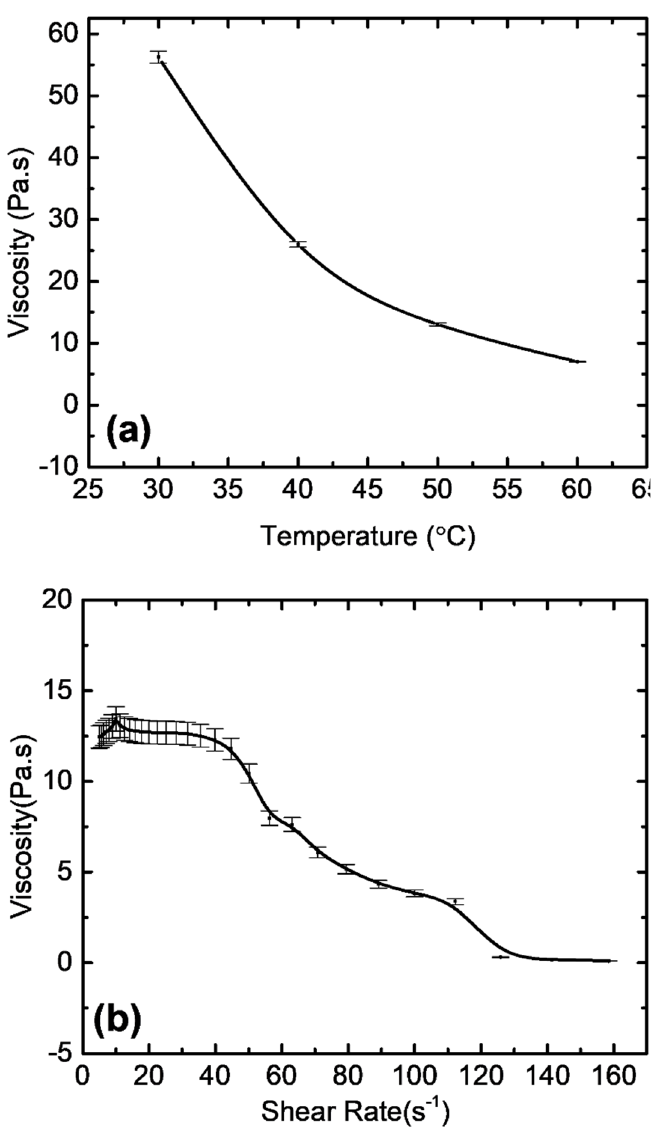
Figure 4. ( a ) Change in viscosity with the temperature at a 10 s − 1 shear rate; ( b ) effect of shear rate on the viscosity of zirconia slurry at 50